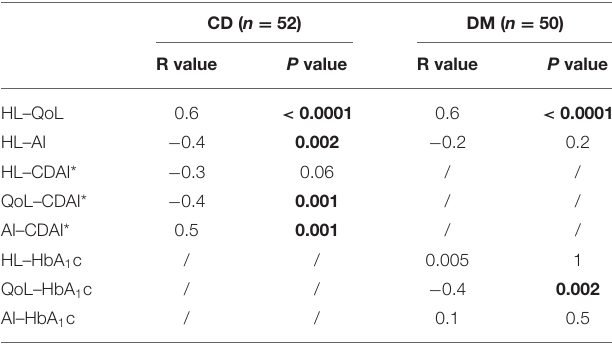
TABLE 5 | Correlations between HL and demographic variables in CD and DM